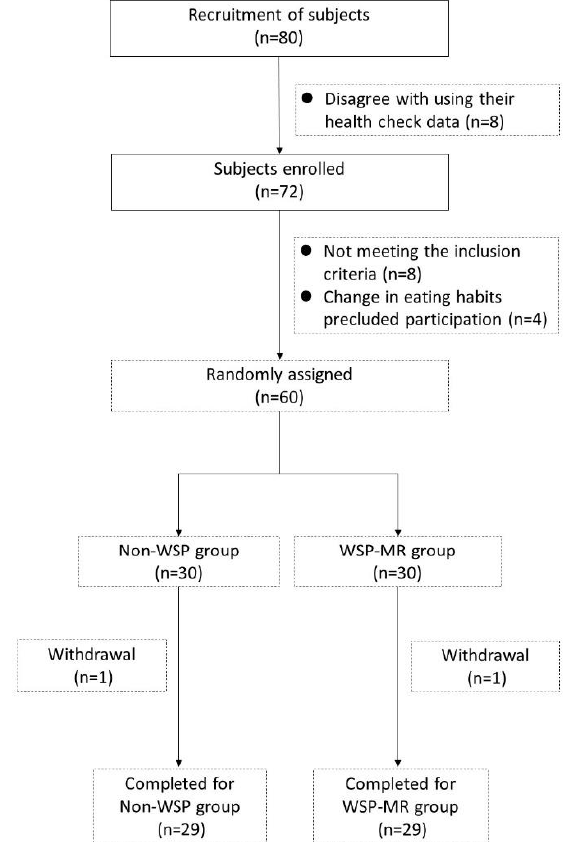
Figure 1. Flowchart of participant selection.